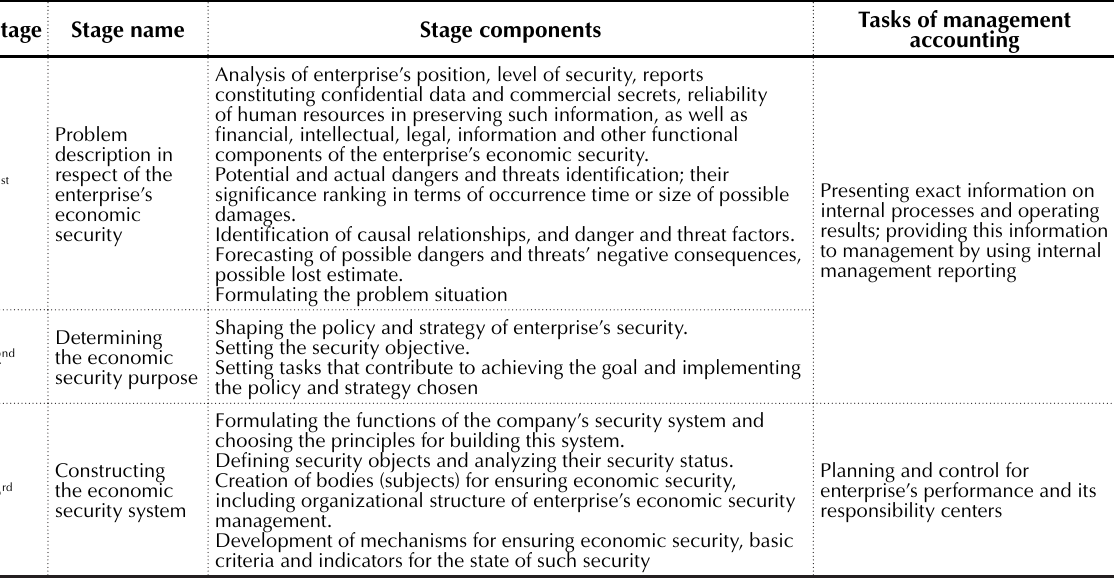
Table 1. Stages of information support of the economic safety management system of an enterprise (in terms of management